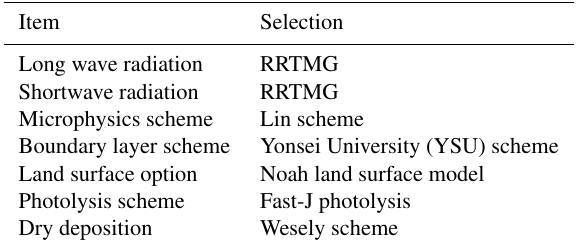
Table 1. Major model configuration options used in the simulations.